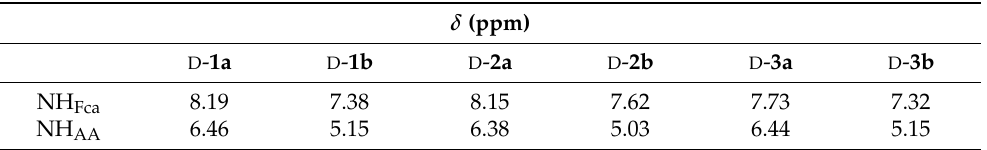
Table 1. Chemical shifts [ δ /ppm] of the NH protons of D - 1a – 3a and D - 1b – 3b in CDCl 3 - d ( c = 5 × 10 − 2 M).